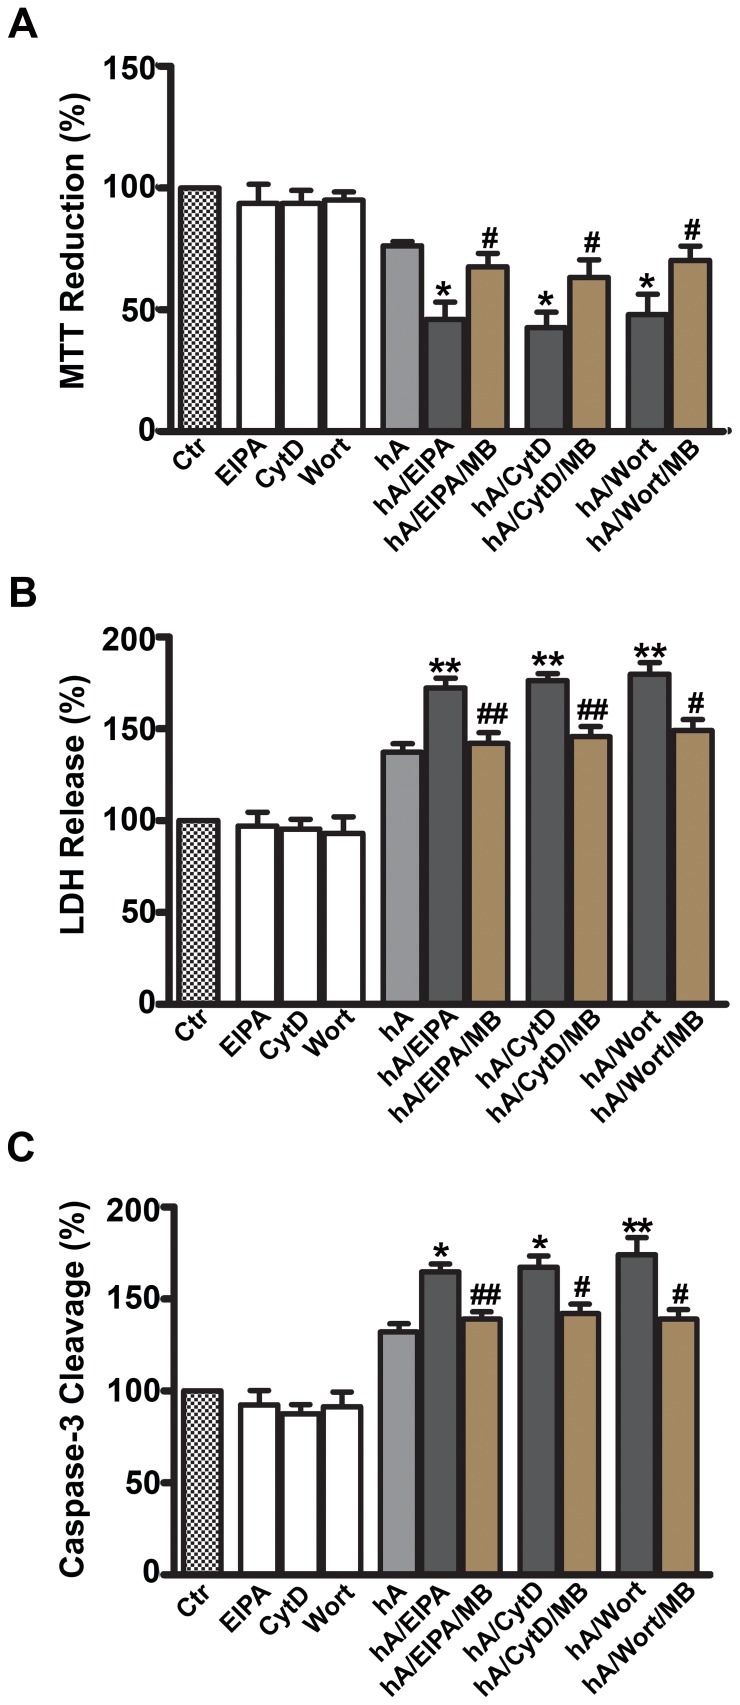
Inhibition of macropinocytosis augments human amylin toxicity in RIN-m5F cells.The effects on cell viability were assessed with MTT reduction (A), LDH release (B) and Caspase-3/7 cleavage (C). Inhibition of macropinocytosis by EIPA, CytD or Wort enhanced human amylin toxicity relative to the control cells (human amylin alone), which in turn was significantly reversed by adding MB. *P<0.05, **P<0.01, hA vs. hA/inhibitors, n = 9 ANOVA followed by Dunnett-Square test and #P<0.05, ##P<0.01, hA/inhibitors vs. hA/inhibitors/MB, n = 9, ANOVA followed by Newman-Keul post hoc test.